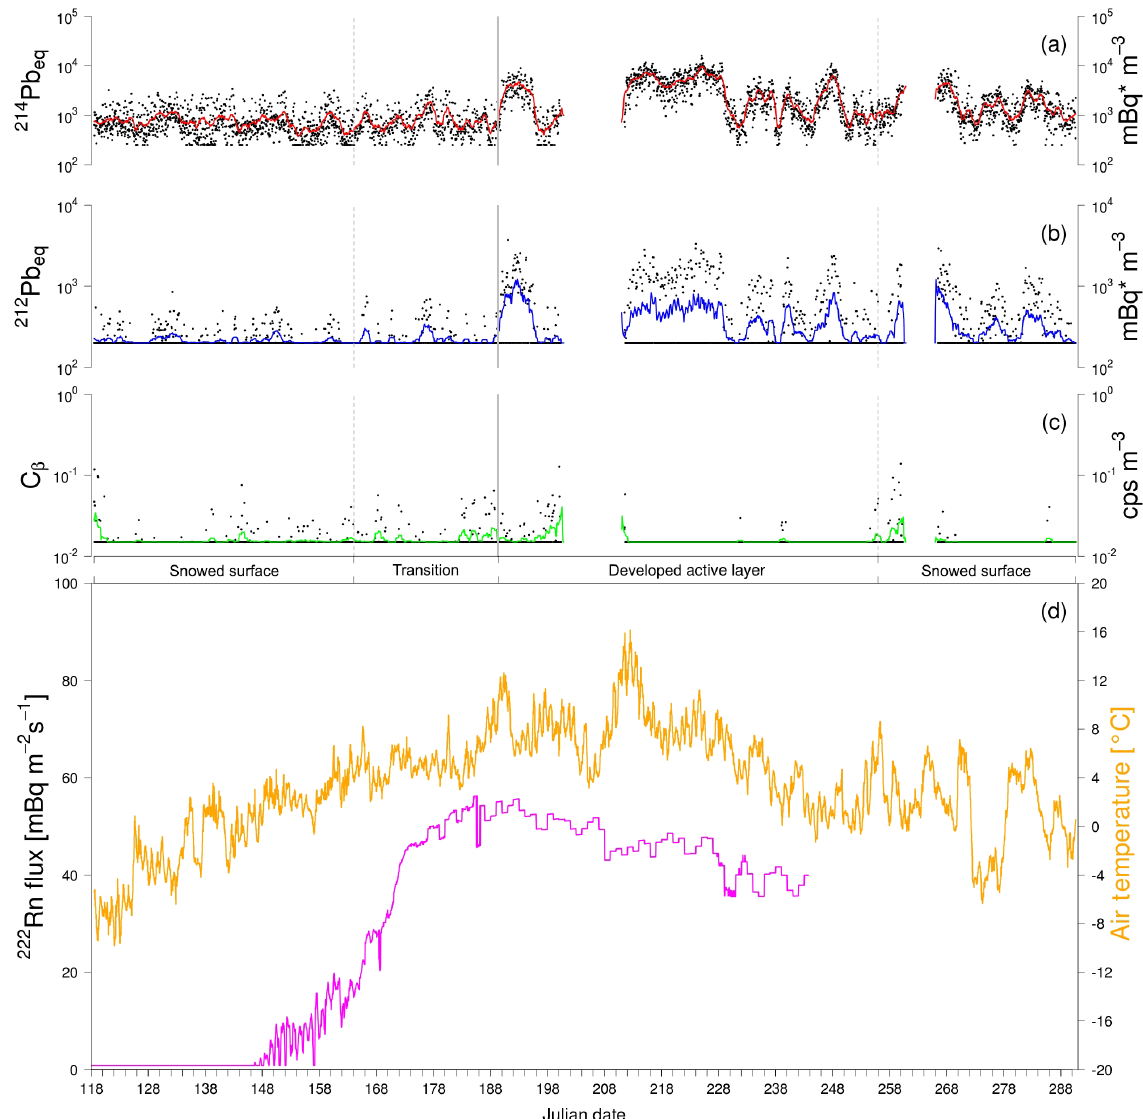
Figure 2. Variability of the three estimated radioactive components (black points) during the campaign at Ny Ålesund in 2015. Colored lines show the smoothed trend of 214 Pb eq (a) , 212 Pb eq (b) and C β (c) . Activities are represented assuming equilibrium between progenies and a bold calibration estimation (*). Comparison of the simulated soil flux (magenta) and the air temperature (orange) (d) . Note the log scale for panels (a–c)